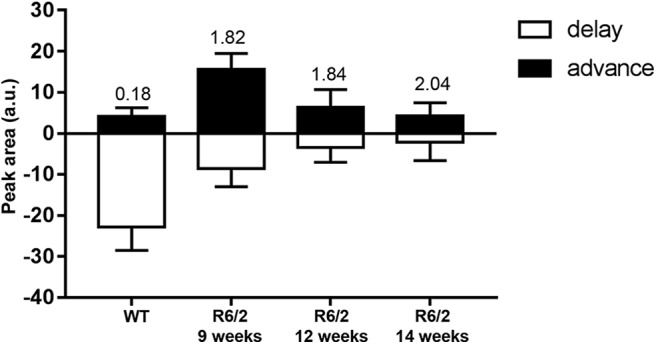
The advance/delay ratio of the phase response curves is altered in R6/2 mice. Graphs show the change of peak area of the phase response curve in response to a 15 min light pulse at 300 lux for R6/2 mice at 9, 12, and 14 weeks of age and for WT mice. The value of the advance/delay ratio is shown above the bars on the graph.